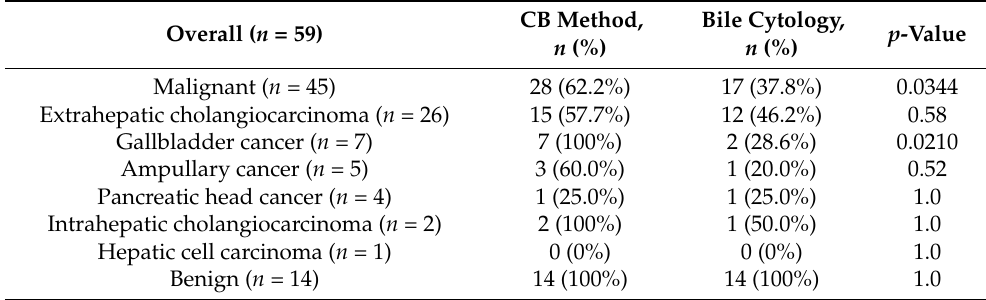
Figure 3. Outline of the process used to reach the final diagnosis. BSC, best supportive care; EC, extrahepatic cholangiocarcinoma; AC, ampullary cancer; GC, gallbladder cancer; PC, pancreatic cancer; IC, intrahepatic cholangiocarcinoma; HCC, hepatic cell carcinoma; IgG4-SC, IgG4-related sclerosing cholangitis; PSC, primary sclerosing cholangitis; BDH, bile duct hamartoma; LC, liver cirrhosis; and AcC, acalculous cholecystitis. Table 2. Comparison of cancer detectability using the cell block (CB) method and bile